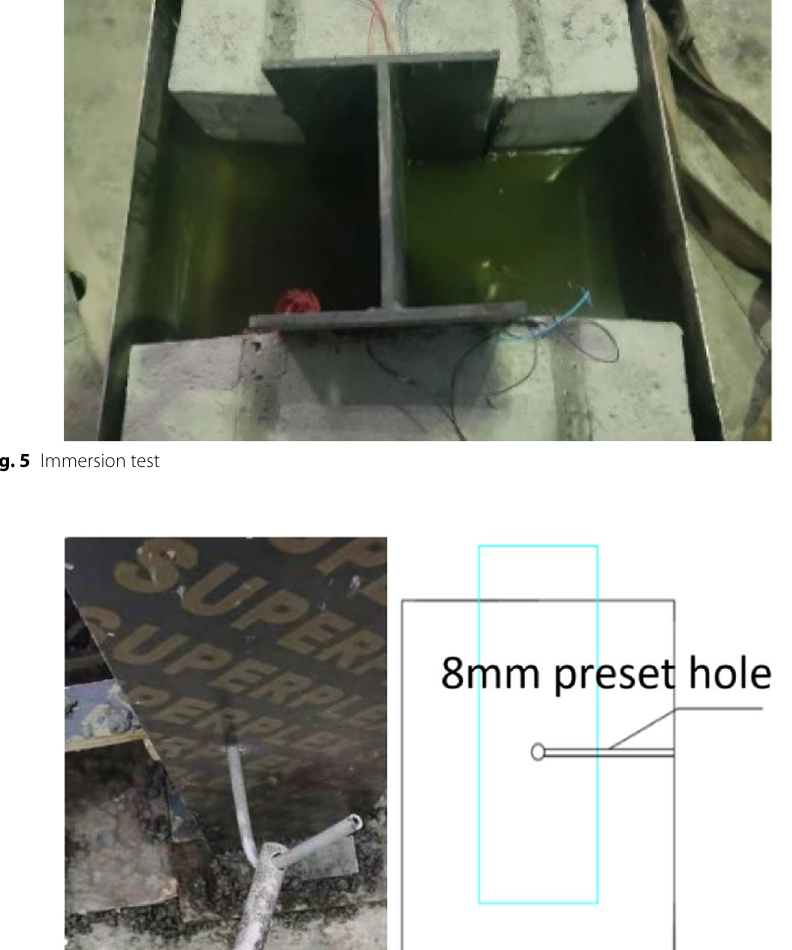
Fig. 6 Preset corrosion path at the root of the